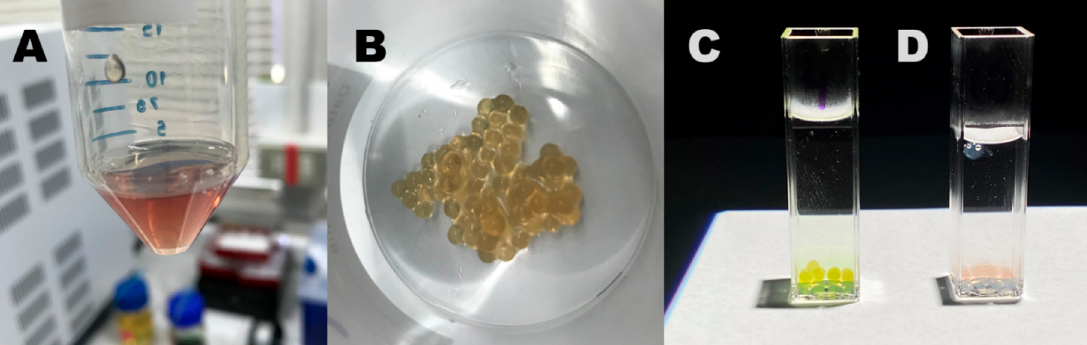
Figure 12. ( A ) Sodium alginate (1.5% w/v) containing the PKHEDA 2 × 10 ⁻ 4 M/TPPS 1 × 10 ⁻ 4 M colloids at pH 6.0; ( B ) freshly prepared calcium alginate beads containing the PKHEDA/TPPS complex; the calcium alginate beads were poured in water at pH 4 ( C ) and 10 ( D